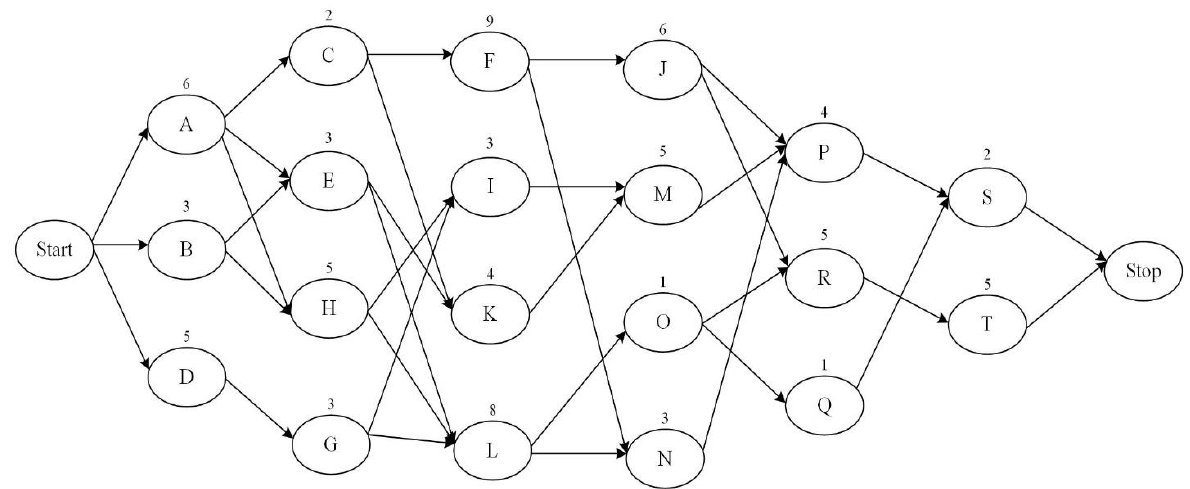
Figure 13. A typical RCPSP example with a daily resource limit=9 [58].